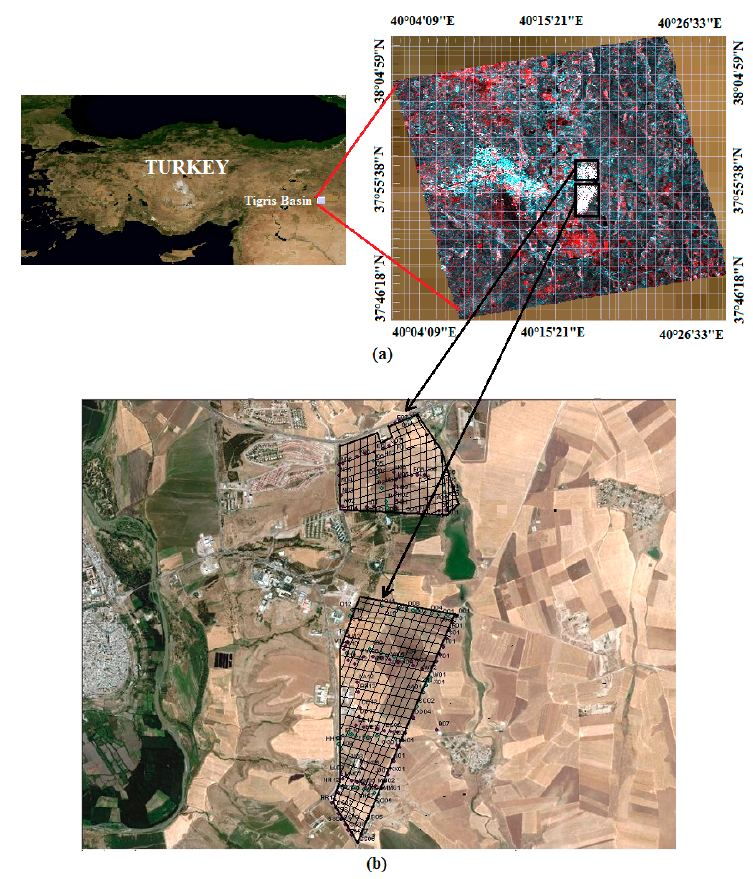
Figure 1. The location of the study area, presented as both ( a ) Radarsat-2 image and ( b ) Google Earth image. The black rectangular areas indicate the coverage of two experimental sites.